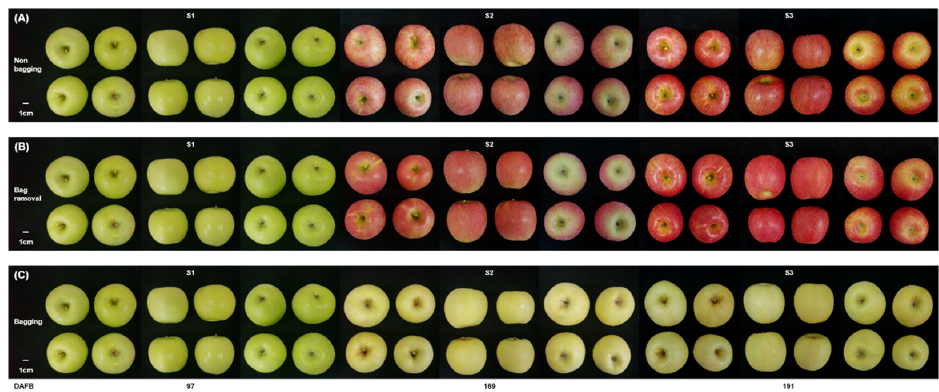
Figure 1. Skin color and pattern changes in ‘Fuji’ apples subjected to ( A ) no bagging (control; labeled as “non-bagging”), ( B ) bagging followed by bag removal (labeled as “bag removal”), and ( C ) bagging with no bag removal (labeled as “bagging”). Apples were harvested at three time points: before paper-bagging (S1, DAFB 97) and then 1 and 4 weeks after bag removal (S2, DAFB 169 and S3, DAFB 191). At maturity (S3), ‘Fuji’ apples display a striped-red color ( A ), a blushed-red color ( B ), and a blushed-yellow color ( C ), depending on bagging treatment. Scale bars equal 1 cm. DAFB, days after full bloom.